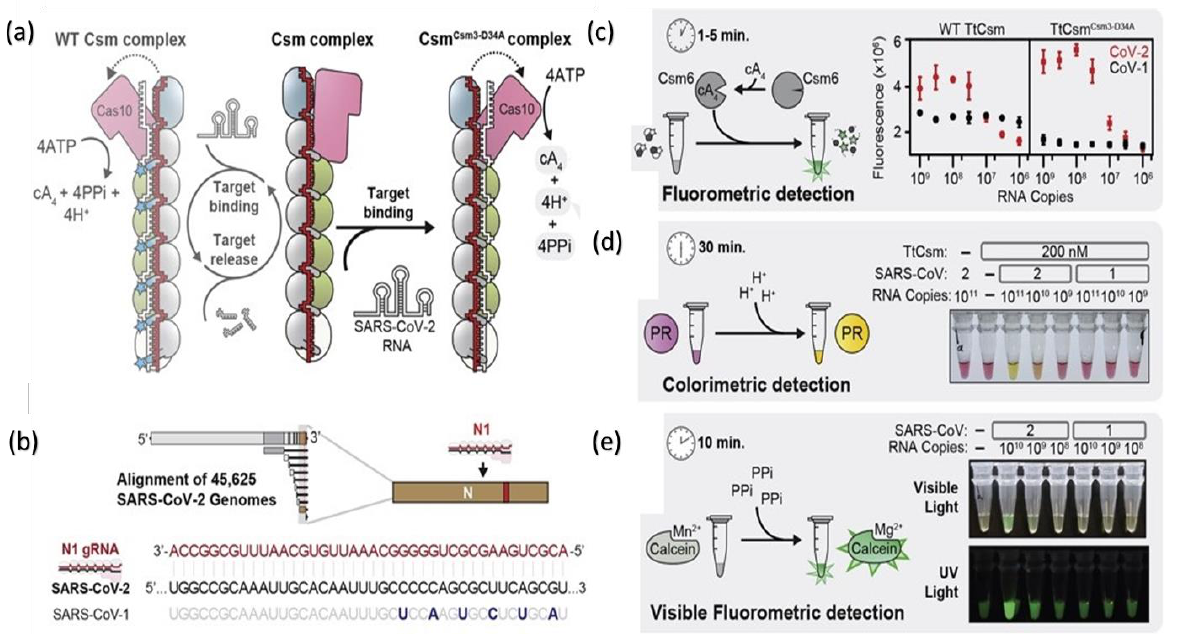
Figure 3. ( a ) A schematic representation of CRISPR Csm complex type III (Thermus thermophilus) consisting of a CRISPR-RNA (red) and a set of 5 stoichiometrically unequal proteins [Cas 101 (pink), Csm41 (blue), Csm36 (gray), Csm24 (green), Csm51 (white)]. Enzymatic cascade (Cas10-polymerase, Cas DNAase and Csm3 RNAase) activates due to the binding of CRISPR-RNA. Csm3 subunits cleave target RNA and the inactivation of Cas10. The complex RNase-dead is generated due to mutant TtCsm Csm-D34A . ( b ) SARS-CoV-2 genome and N1 region of CRISPR RNA (crRNA N1 ). ( c ) Fluorometric detection, a transcribed SARS-CoV-2, and N-gene of SARS-CoV-1. A non-sequence-specific ancillary nuclease, cyclic tetra-adenylate (cA 4 ), activates the TtCsm6.RNA tether furnish link between a fluorophore ( ) to a quencher ( ). Mutant in the right graph showed a lower LOD (3-folds) than the wild in the left graph. ( d ) Colorimetric detection of SARS-CoV-2 by mutant N1 complex by a dye phenol red (a pH-sensitive dye) incubated at 60 ◦ C for 30 min. ( e ) Visible fluorometric detection by the mutant N1 complex using calcein, incubated for 60 min at 60 ◦ C